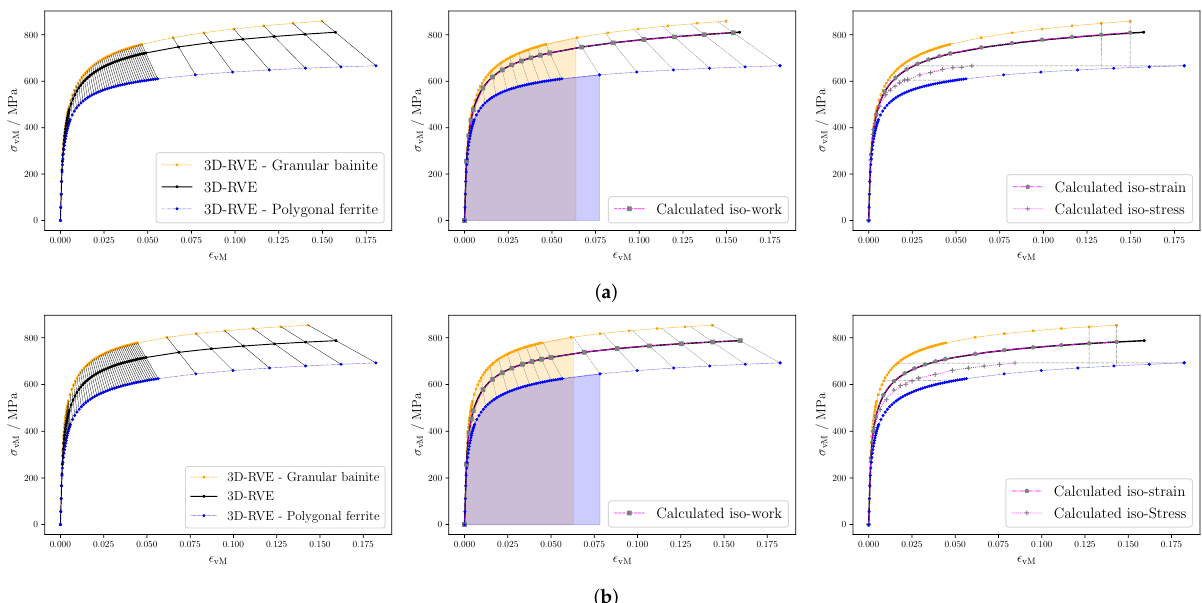
Figure 14. Stress–strain curves for the simulation output (left column), for the iso-work assumption (middle), and for the iso-stress and iso-strain assumptions (right column) in materials S 1 ( a ) and S 2 ( b